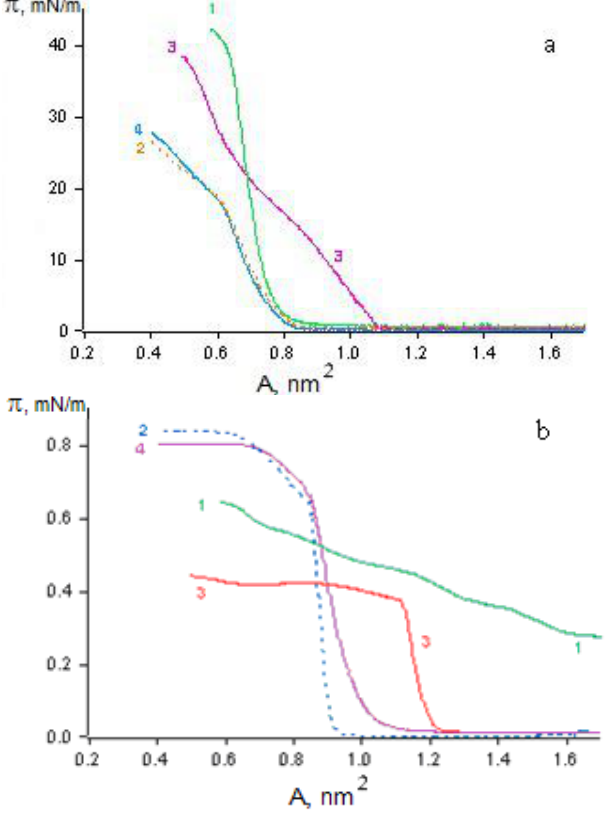
Figure 6. ( a ) Surface pressure (π); and ( b ) surface potential (∆V), as a function of the surface area (A) per butadienyl derivatives of crown ethers (BDCE) molecule in monolayers formed on the surface of (1) distilled water, and 1 mM solutions of (2) KClO